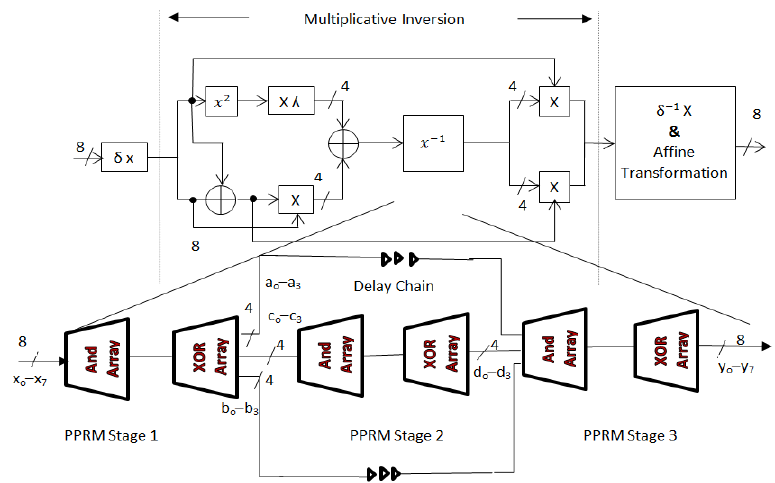
Figure 4. PRRM based SubByte transformation.